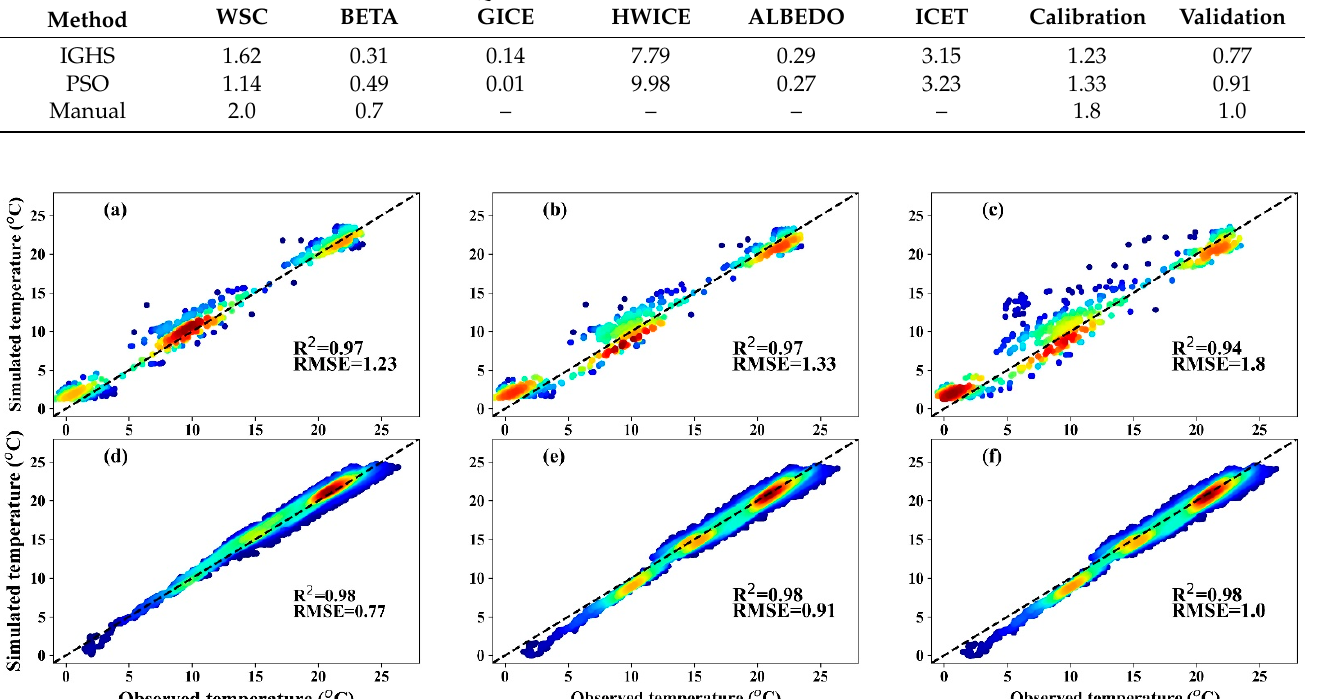
Figure 7. Comparison of Devils Lake water temperatures between simulation and observation. ( a – c ) Simulated by CE- QUAL-W2 model that was calibrated by using IGHS, PSO, and manual [11] methods, respectively, during the calibration period. ( d – f ) Same as ( a – c ) but for validation period. Dark blue and red colors represent low and high density of water temperature data.